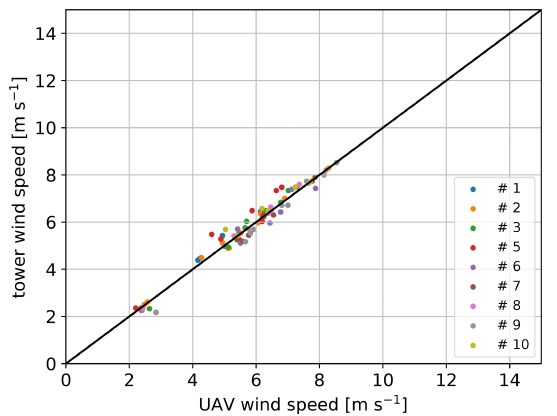
Figure 5. Average wind speed for n = 12 flights from the second week drone vs. tower using the universal parameter – only individ- ual pitch offset is calibrated from flight number 31 and 56 (sce- nario